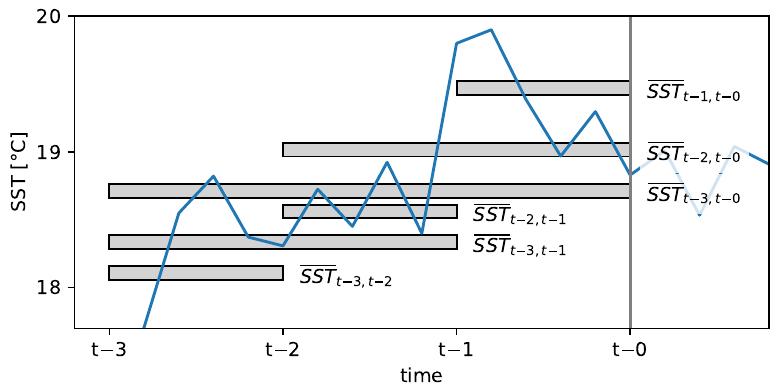
Figure 2. Illustration of the moving window of a flexible size for a time series of sea surface temper- ature (SST). V. vulnificus sampling took place at time t − 0. The grey bars on the time axis indicate the subset of the time series covered by the different windows, while the location on the SST axis indicates the average SST within the different periods. SST t − 3, t − 1 denotes the average SST in the time window between t − 3 and t −